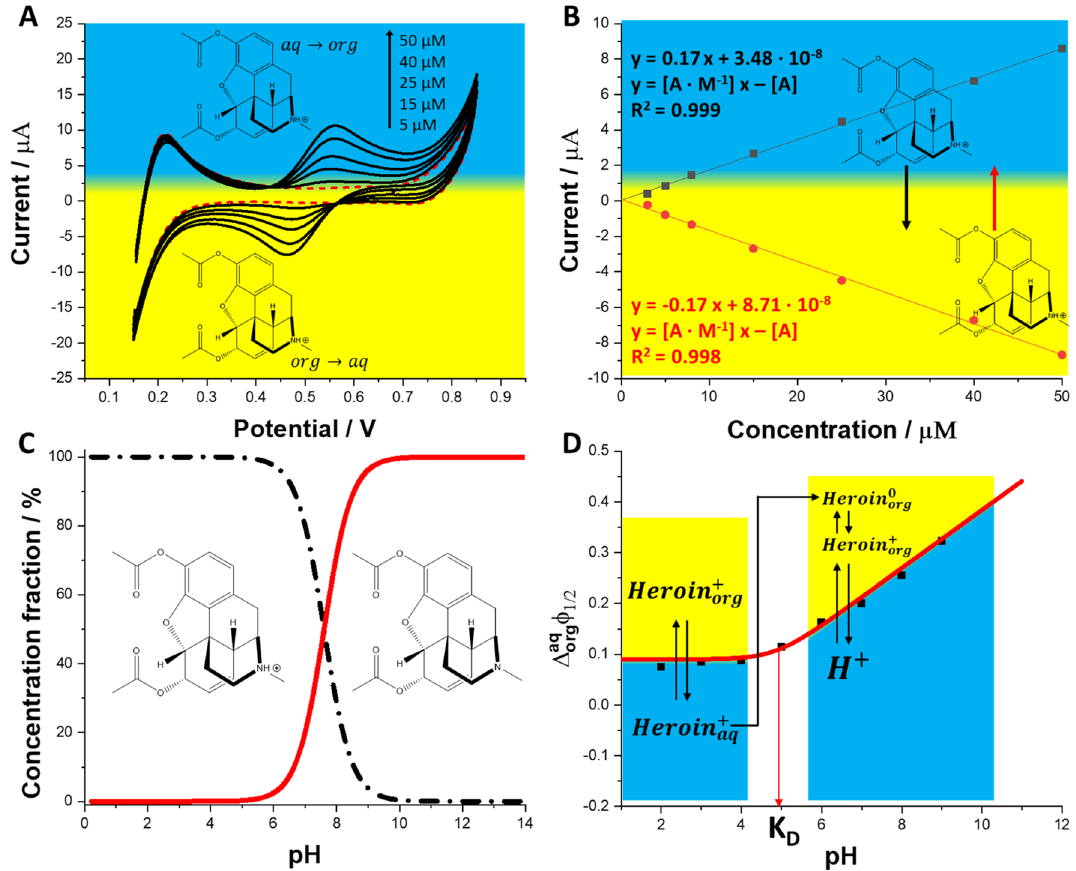
Figure 1. ( A ) – Cyclic voltammograms (CVs) recorded in the absence (red, dashed line) or in the presence (black, solid lines) of heroin initially present in the aqueous phase (10 mM HCl in 10 mM NaCl; pH = 2; scan rate 20 mV·s −1 ; concentrations of heroin are marked in the right upper corner of the figure). ( B ) – Calibration curves plotted based on the positive and negative ionic currents attributed to the heroin transfer from the aqueous to the organic and from the organic to the aqueous phase, respectively. Liner fitting equations are given next to the corresponding calibration curves. ( C ) – Concentration fraction diagram plotted for heroin (pK a = 7.6). ( D ) – Ionic partition diagram plotted for heroin. For details see the corresponding discussion.